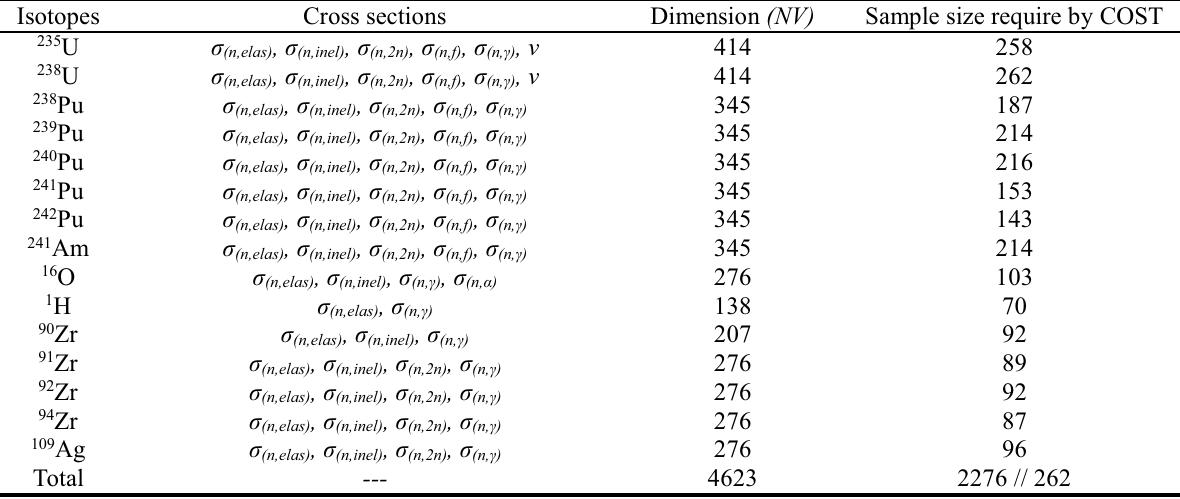
Table Ⅱ. The isotopes and corresponding cross sections in uncertainty analysis Isotopes Cross sections Dimension